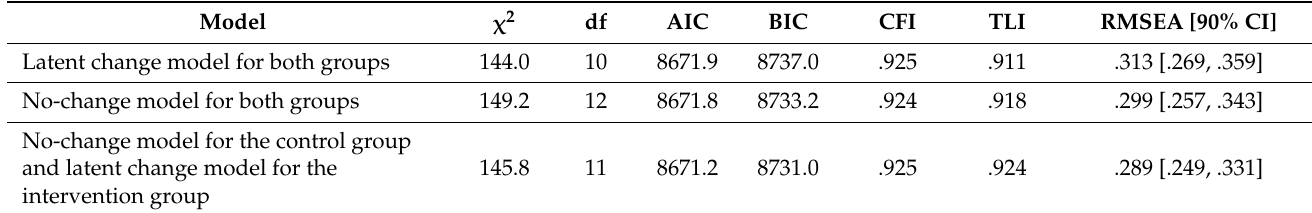
Table 8. Goodness-of-fit indices for the models tested on the test level in the second dimension (development between the pre- and follow-up